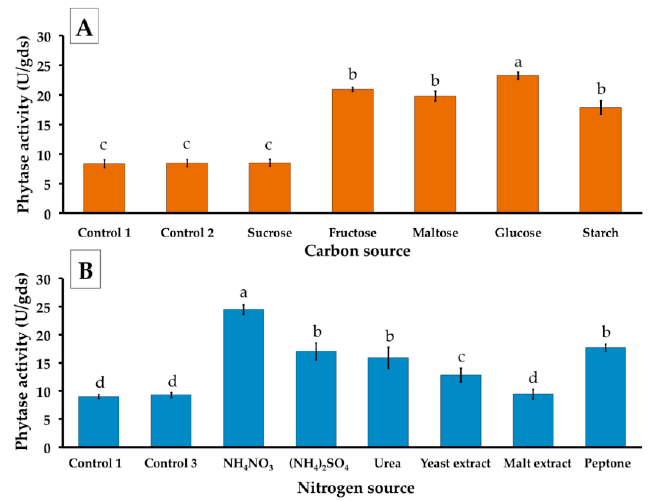
Figure 3. Effect of different nutrient sources for phytase production from P. adiposa using water hyacinth in SSF. ( A ) Carbon sources and ( B ) Nitrogen sources. The results are means ± SD. Different letters above each bar in the same parameter indicate the significant difference ( p < 0.05).